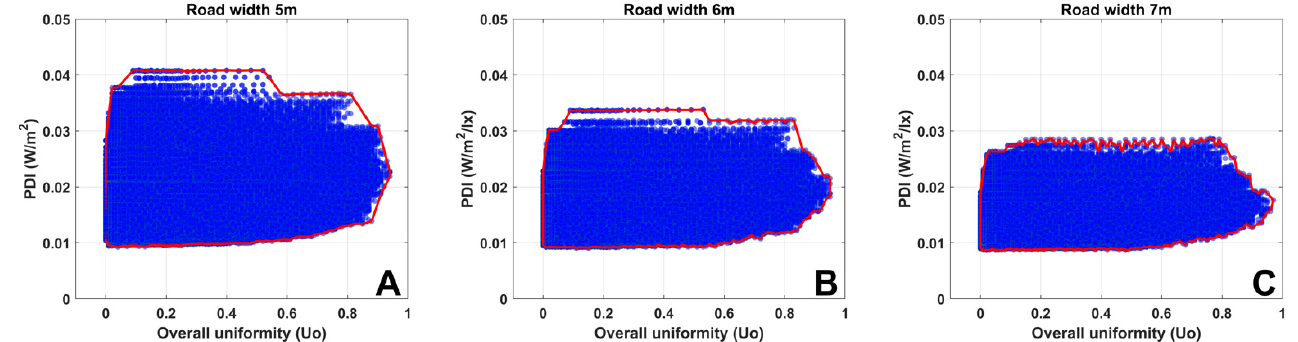
Figure 6. Overall uniformity of illuminance vs. PDI; simulation results for all cases (around half a million for each road width) surrounded by the red boundary line of the technically possible solutions. The graphs include all potential pole arrangements, as shown in Table 1: ( A ) results for road width of 5 m; ( B ) results for road width of 6 m; ( C ) results for road width of 7 m.